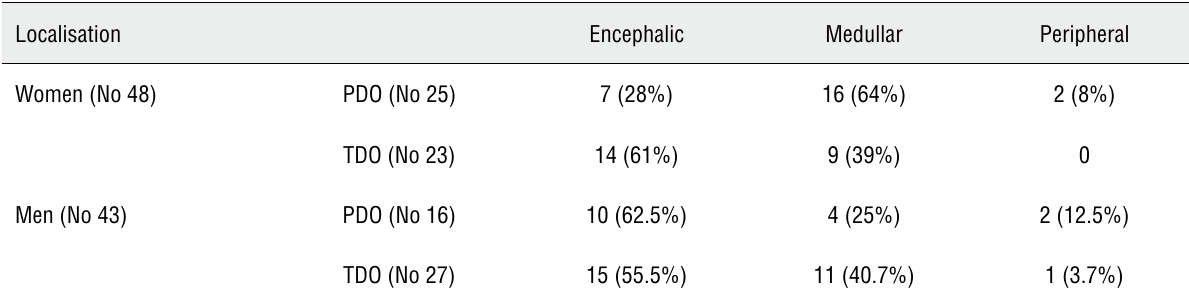
Table 1 - Localisation of the neurological lesion in each gender vs. pattern of detrusor overactivity (PDO: phasic detrusor overactivity, TDO: terminal detrusor overactivity).